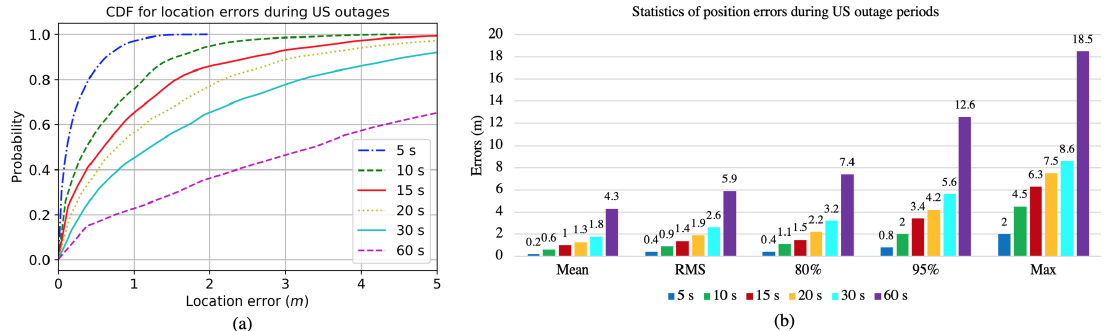
Figure 13. ( a ) CDF and ( b ) statistics of 2D location errors during ultrasonic outage